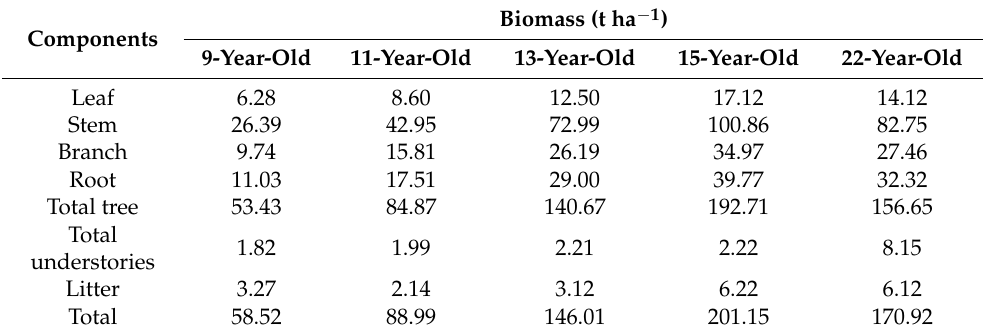
Table 4. Biomass of different ecosystem components in the 9-, 11-, 13-, 15-, and 22-year-old T . Zhongshanshan stands.